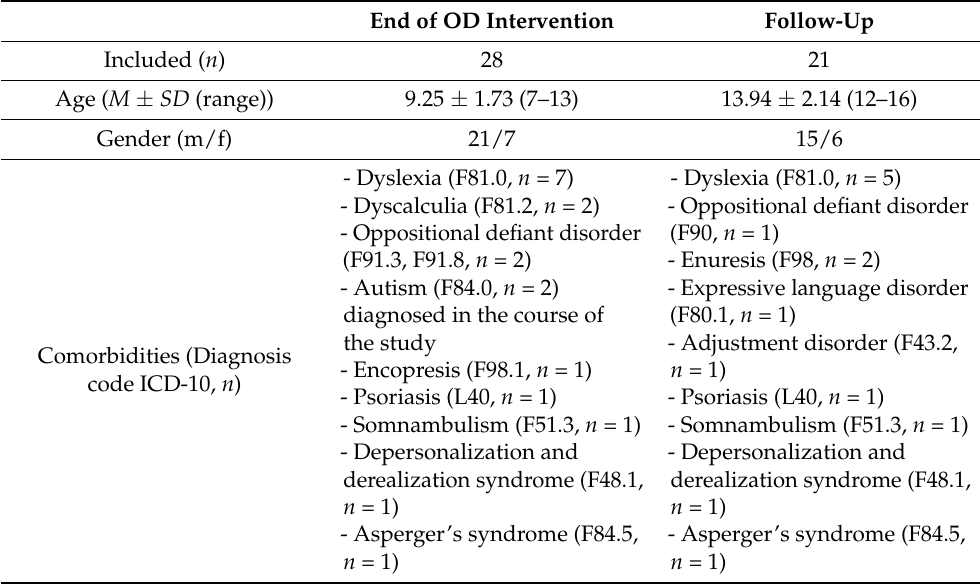
Table 1. Characteristics of participants at (1) end of the OD intervention and (2) at follow-up approximately 3.5 years